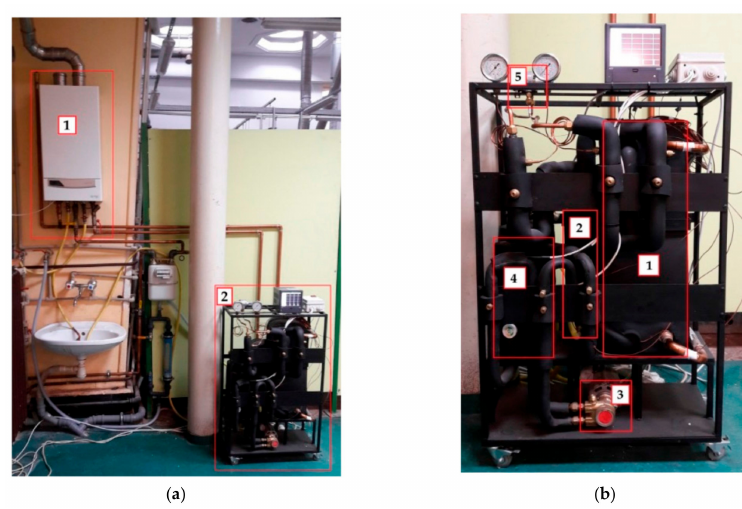
Figure 8. A general view of a micro-power ORC test stand implemented in 2009 at the Wrocław University of Technology. ( a ) A view of the gas boiler (1) and the test stand (2); ( b ) A view of the test stand and components: evaporator (1), condenser (2), multi-vane pump (3), working fluid reservoir (4), and multi-vane expander